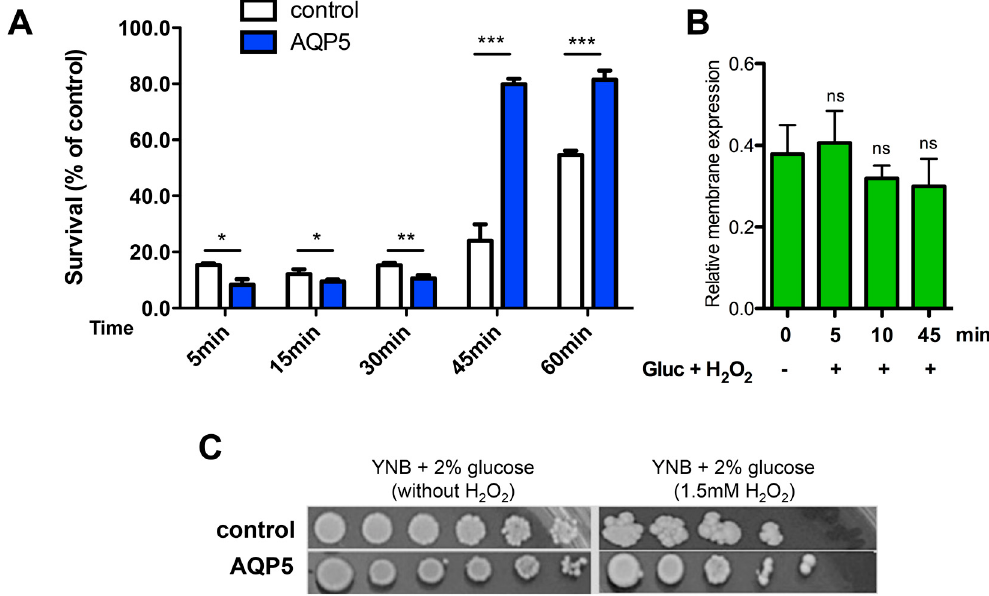
Figure 6. Stress response of yeast strains to H 2 O 2 . ( A ) Acute stress response. Time course of cell survival of yeast cells in liquid culture after treatment with 0.5 mM H 2 O 2 . Percentage survival is expressed relative to untreated controls. Values are means ± SD of triplicates. * p < 0.05, ** p <